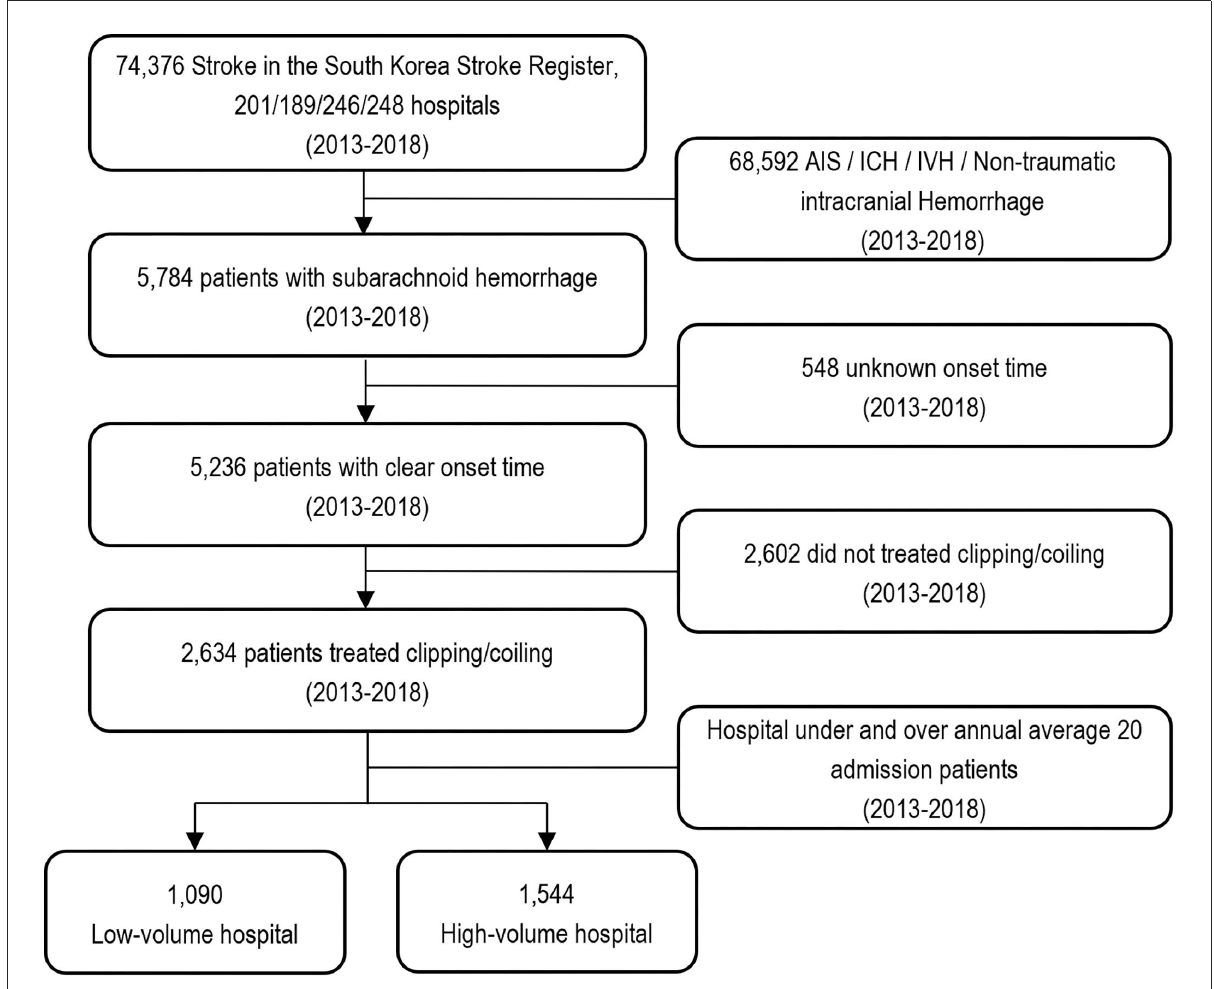
FIGURE1 Flow chart of the study population and patients with subarachnoid hemorrhage according to hospital